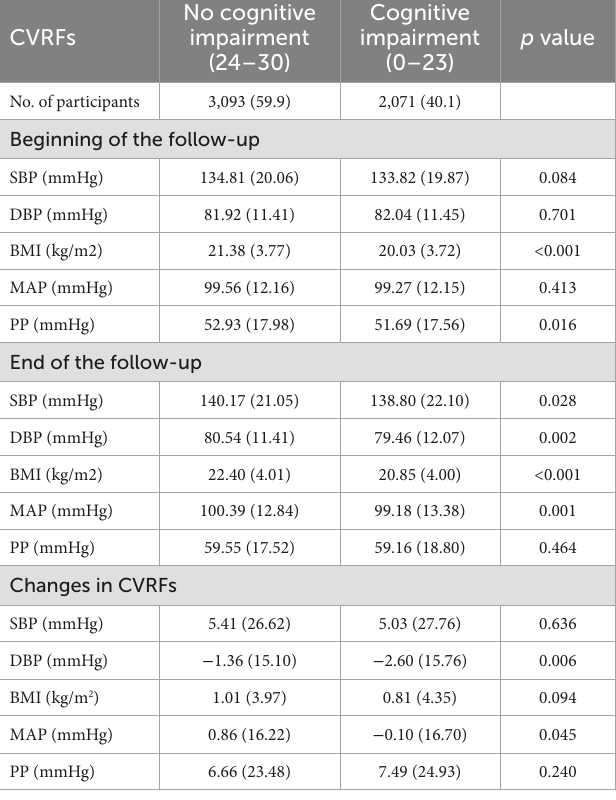
TABLE 2 CVRFs among participants with and without cognitive